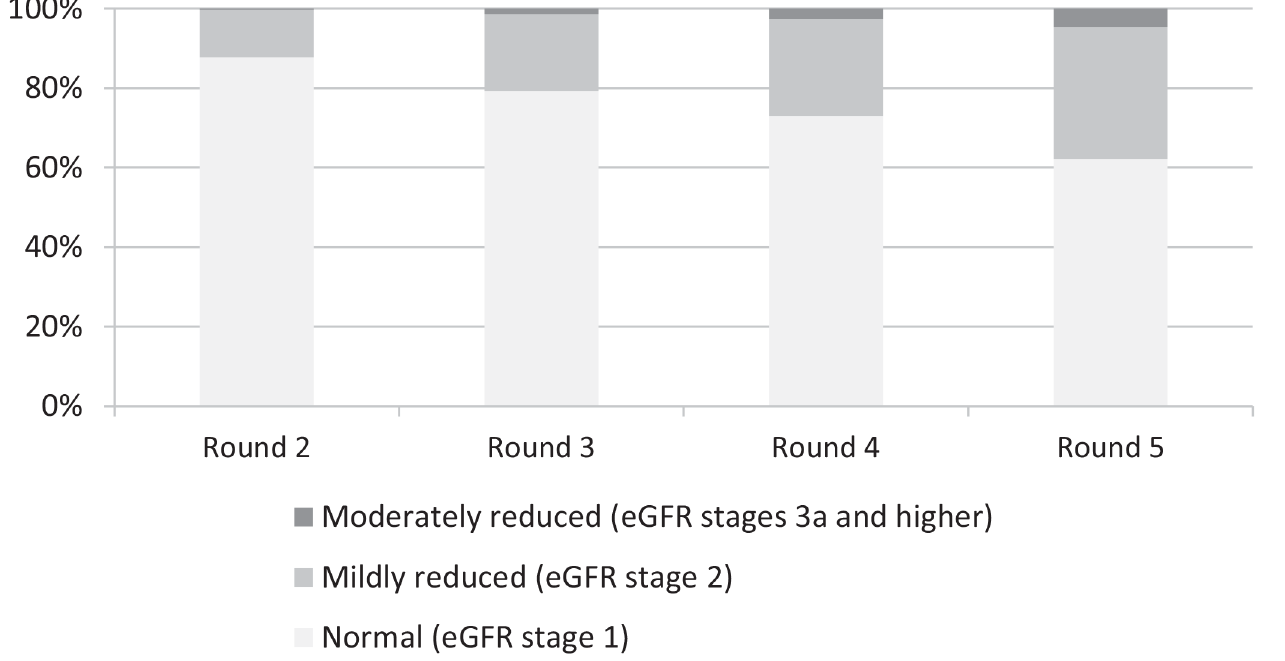
Fig 2. Prevalence of the various eGFR stages during the various screening rounds. Abbreviation: eGFR: estimated glomerular filtration rate.